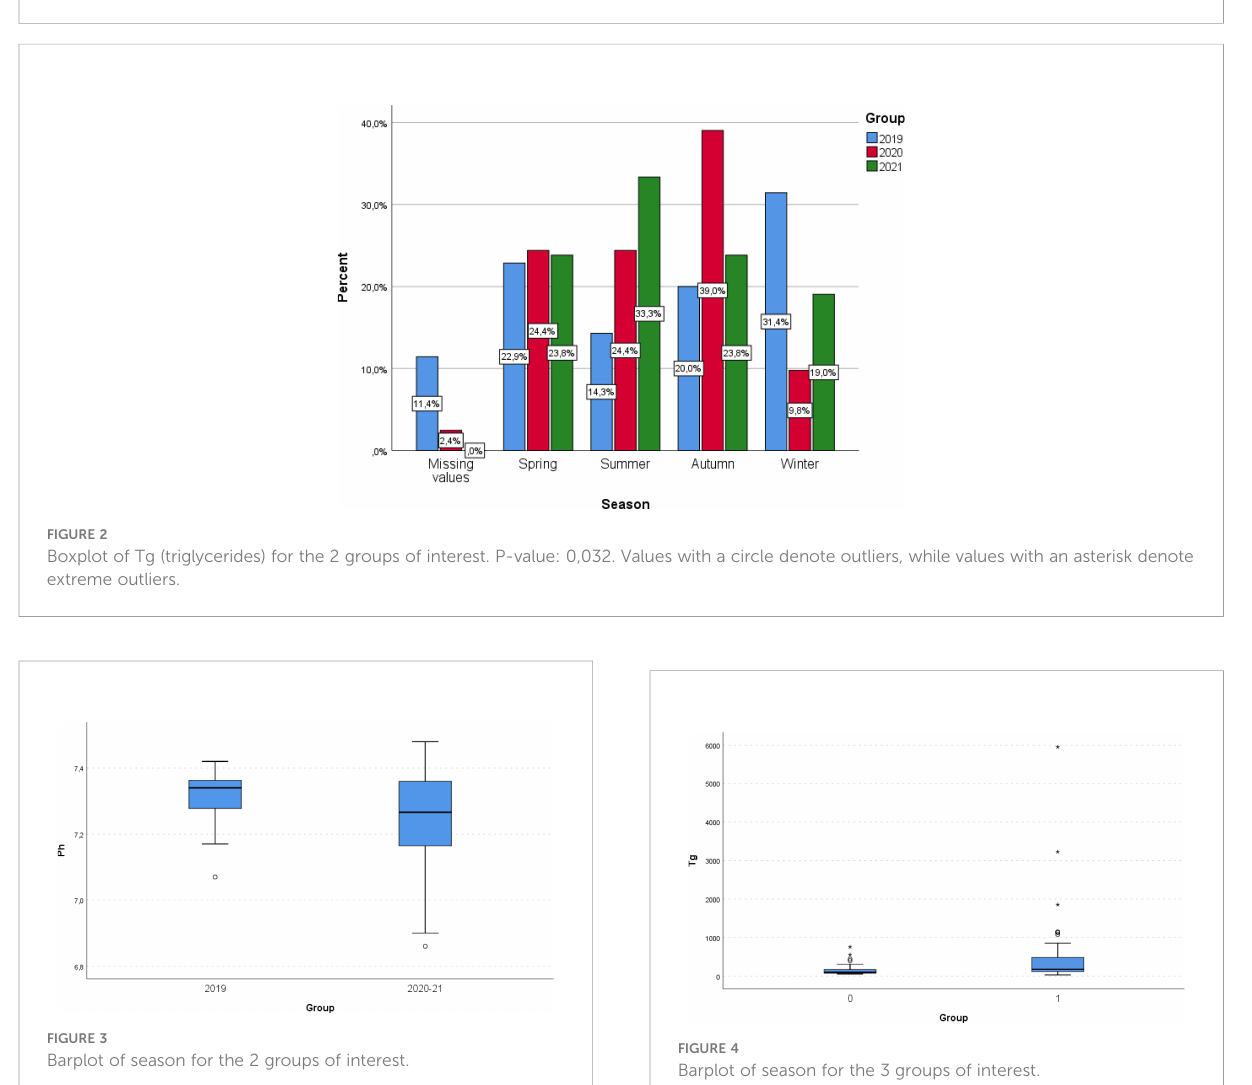
FIGURE 1 Boxplot of Ph for the 2 groups of interest. P-value: 0,021.